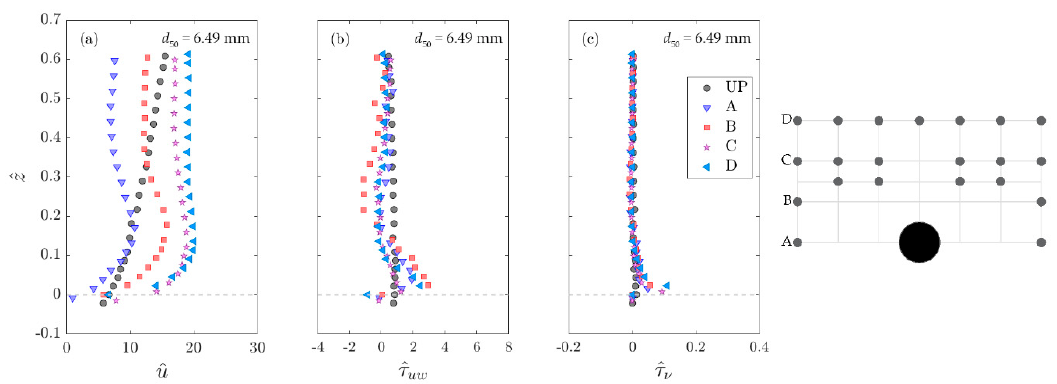
Figure 15. Vertical distributions of ( a ) dimensionless time-averaged velocity, ( b ) dimensionless Reynolds shear stress, and ( c ) dimensionless viscous shear stress measured at x = 0 in Run 2.